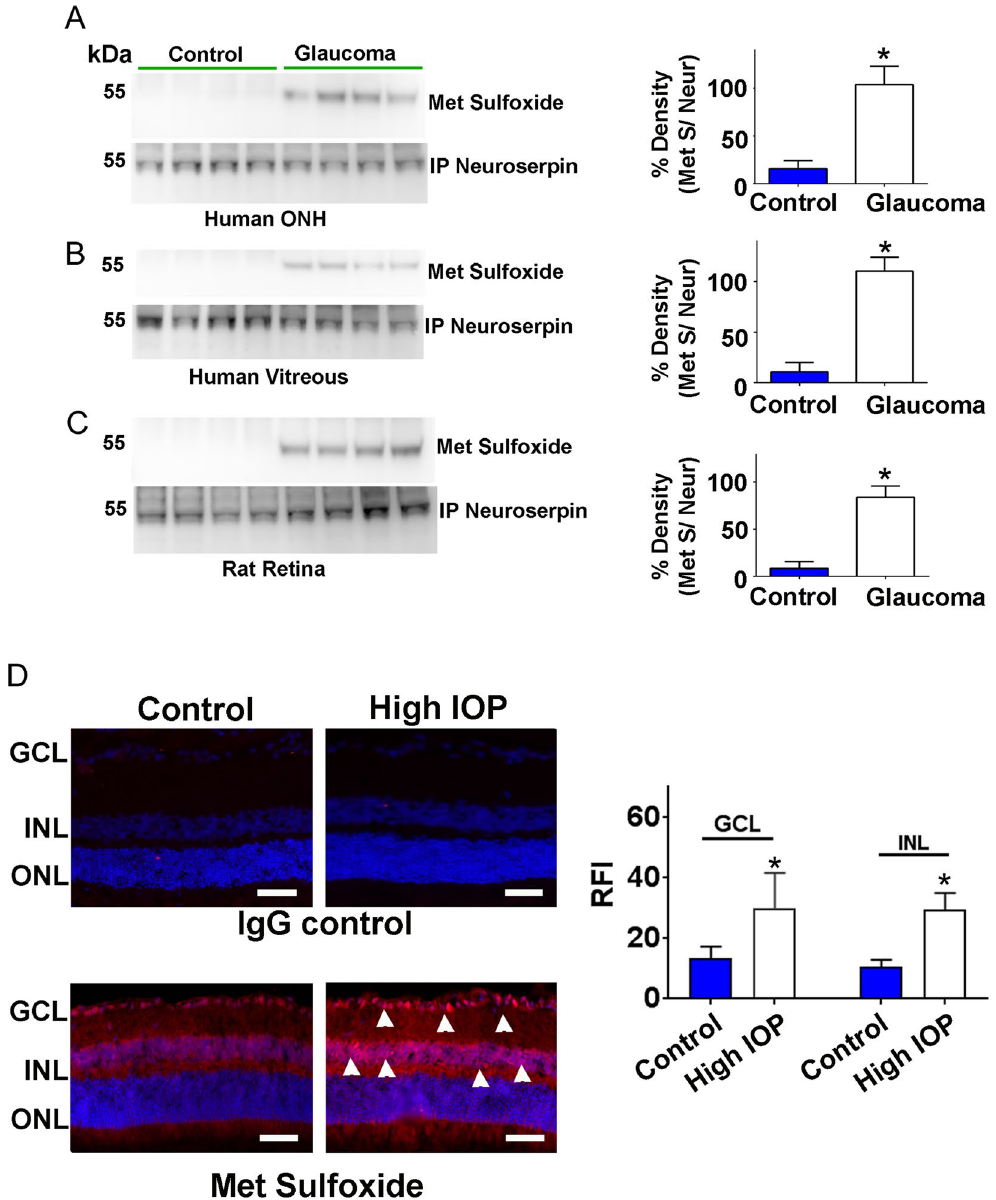
Figure 7. Neuroserpin was immunoprecipitated from control and glaucomatous ( A ) human retinas ( B ) vitreous and from ( C ) the rat retinas. The immunoprecipitates were blotted and probed for methionine sulfoxide immunoreactivity. The blots were also probed with anti-neuroserpin antibody in each case. Blots were cropped to show the relevant bands. Relative band intensities were quantified in each case and plotted (n = 4; * p < 0.001). ( D ) Rat retinal sections from control and high IOP induced eyes were immunostained with either IgG control or met sulfoxide antibody (red), DAPI (blue). Arrows (white) highlight the increased met sulfoxide staining in the inner retinal layers of high IOP subjected rats. The average relative fluorescence intensities for met sulfoxide reactivity in sections (n = 4) were quantified in GCL and INL of retinas using ImageJ, compared using students t-test and plotted with standard deviation and error bars (Scale 50 µ m, * p <